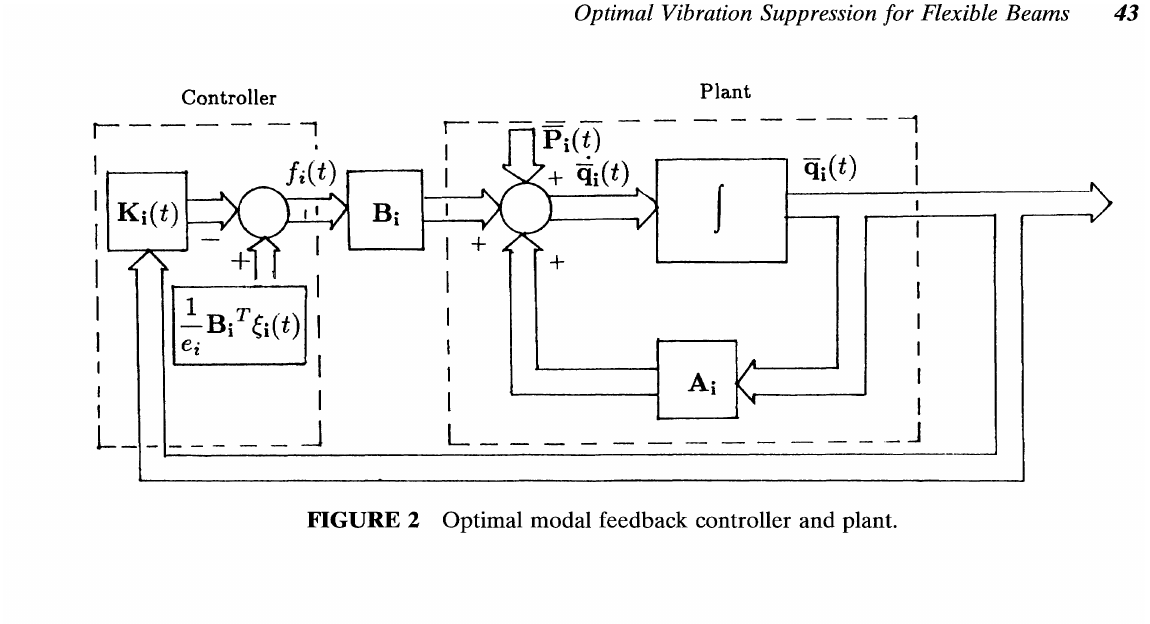
FIGURE 2 Optimal modal feedback controller and